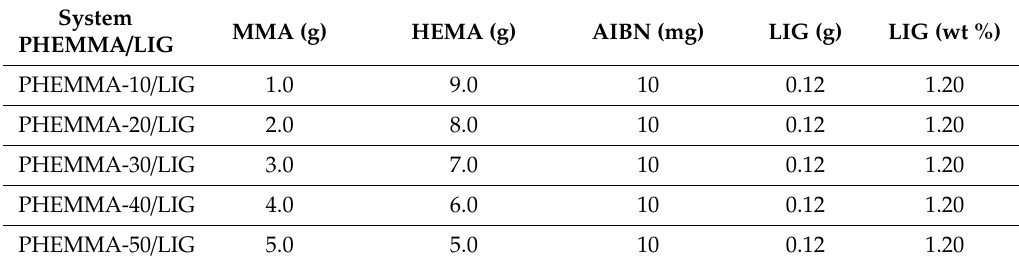
Table 2. Preparation conditions of PHEMMA / lignocaine (LIG)